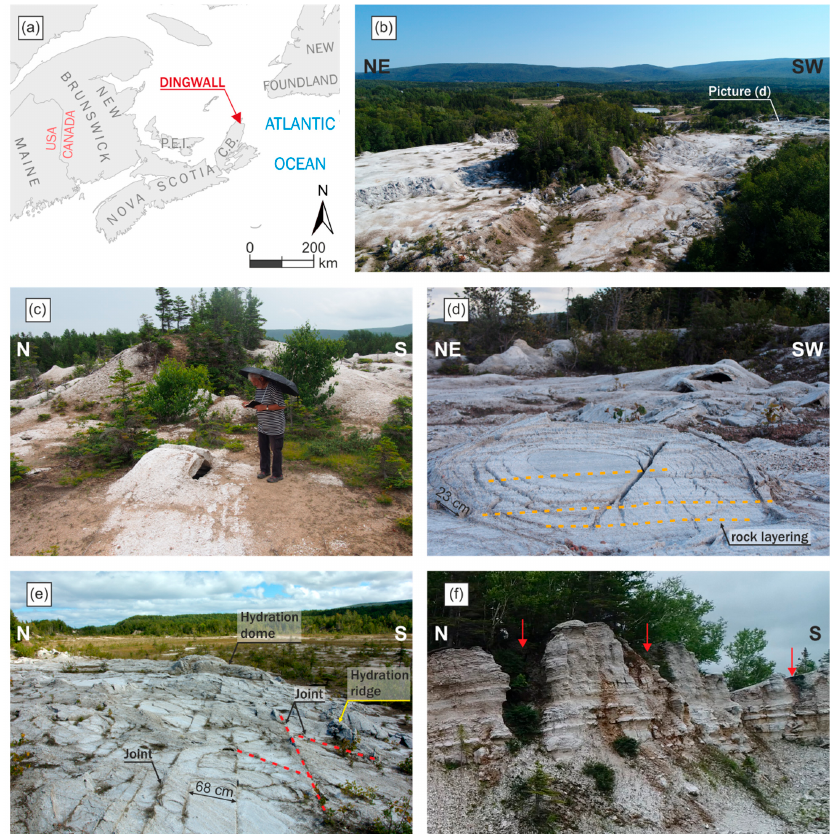
Figure 1. Location of the studied abandoned gypsum quarry at Dingwall ( a ) and photographs of the site ( b – f ); b–central field of the quarry seen from the north; ( c )–exemplary hydration dome along with internal void and with Firouz Vladi next to it; ( d )–bottom of the quarry (see b ) with spheroidal fractures related to spheroidal weathering (similar to cannonball structures from New Brunswick [39]), note layering (marked by dotted yellow line) and hydration domes with cavern or cave in the background; ( e )–bottom of the quarry in eastern field showing regular joint system (marked by red dotted lines) and hydration forms; ( f )–sinkholes (schlottenkarren; marked by red arrows) seen in the quarry wall in central field.